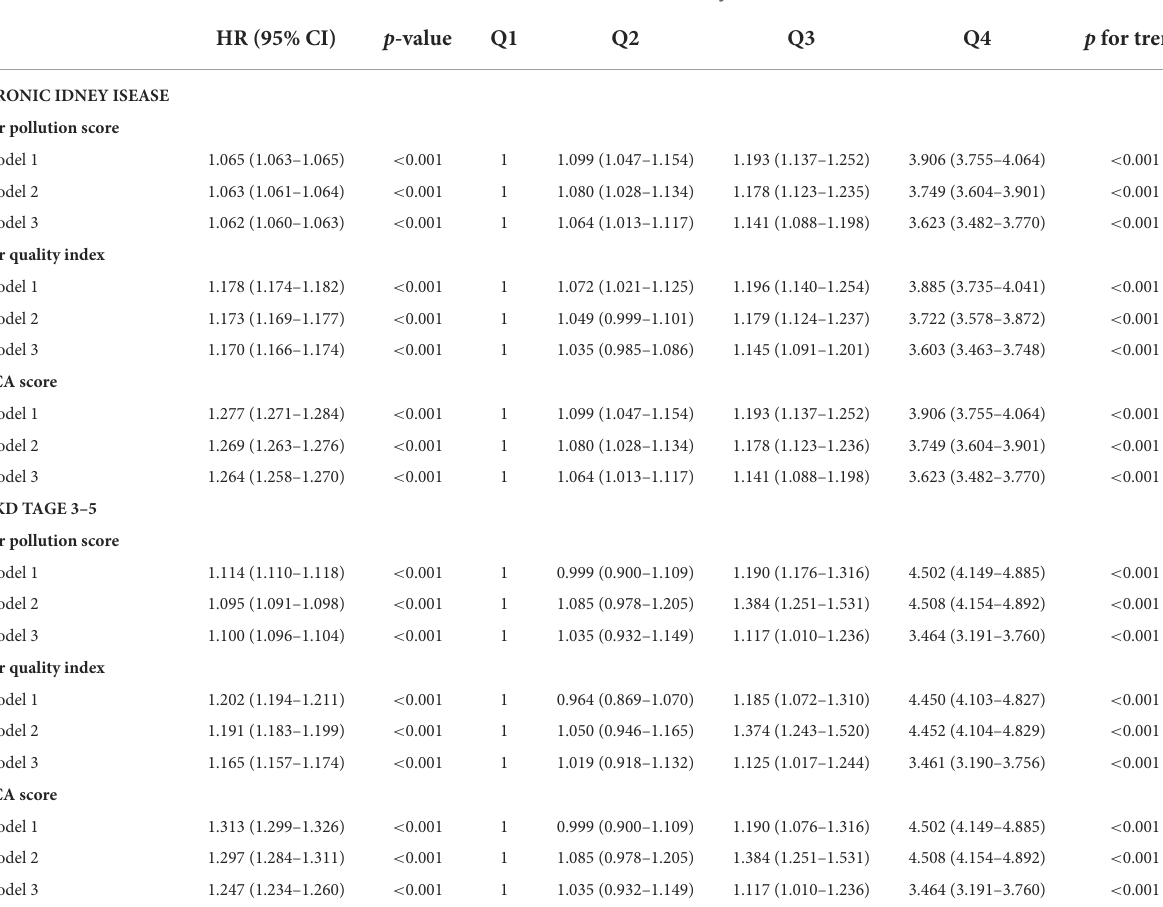
TABLE 3 Hazard ratios and 95% confidence interval for the risk of incident CKD in the